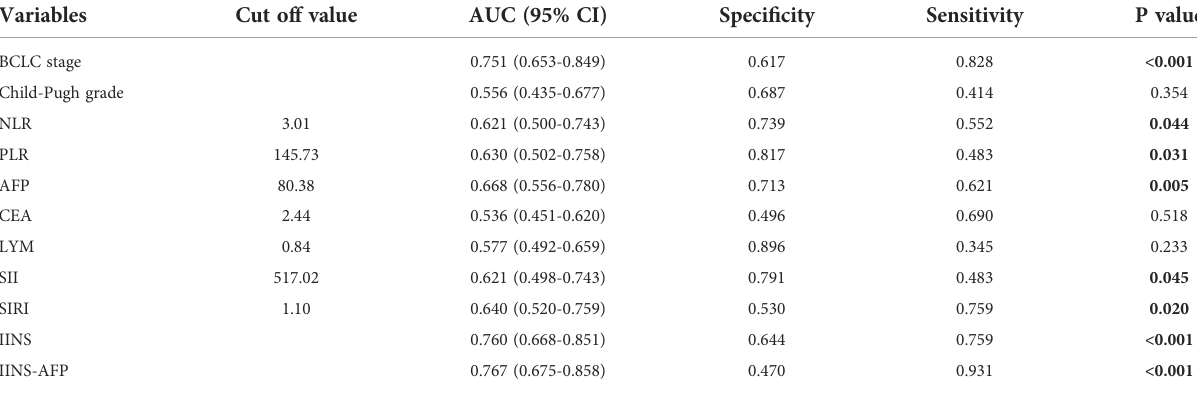
HCC, hepatocellular carcinoma; BCLC, Barcelona Clinic Liver Cancer; AFP, alpha-fetoprotein; CEA, carcinoembryonic antigen; LYM, lymphocyte; NLR, neutrophil – lymphocyte ratio; PLR, platelet – lymphocyte ratio; SII, systemic immune-in fl ammation index; SIRI, systemic in fl ammation response index; IINS, in fl ammation-immunity-nutrition score. Bold values means the P value is signi fi